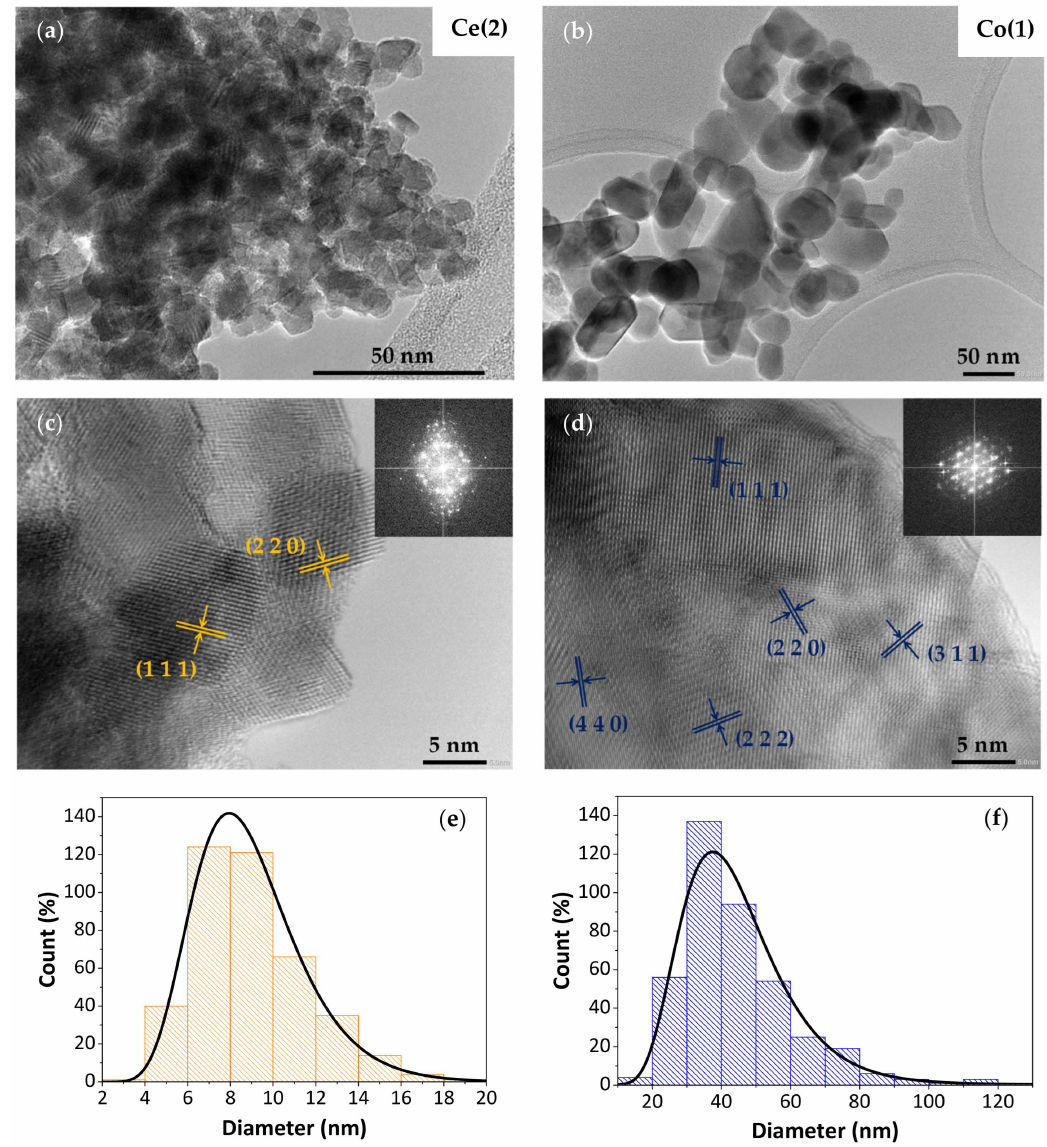
Figure 5. TEM and HR-TEM images and size distribution of the synthesized particles: ( a , c , e ) Ce(2) and ( b , d , f ) Co(1). Insets: FFT